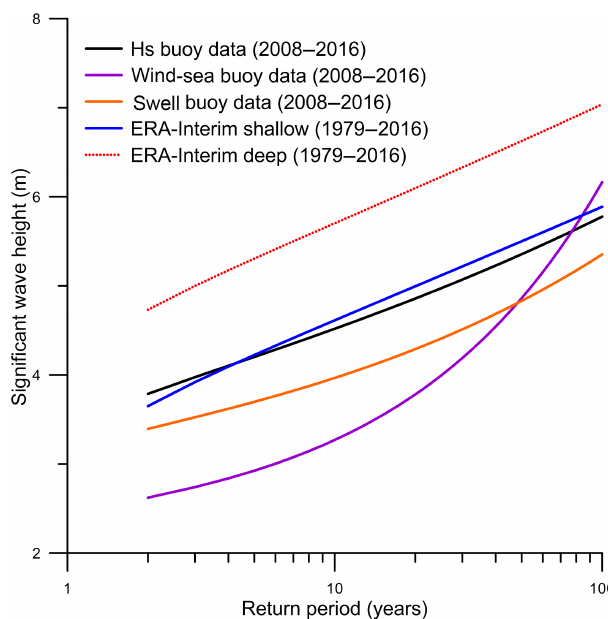
Figure 8. Return levels of significant wave heights for different re- turn periods based on buoy data (2008–2016), ERA-Interim shallow water data and ERA-Interim deep water data (1979–2016) at 6h in- tervals by the GEV model using annual maxima